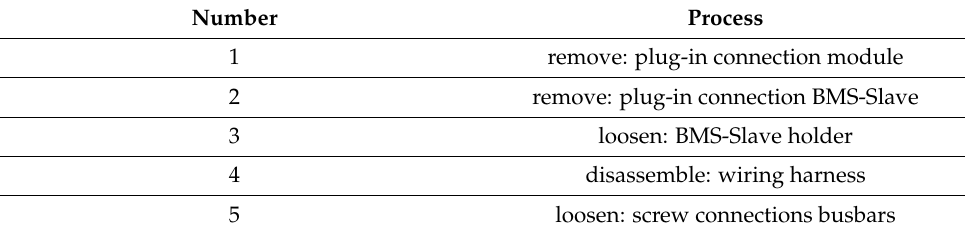
Table A9. Activities of the main processes “classification” and “disassembly”: disassembly periphery (inside).